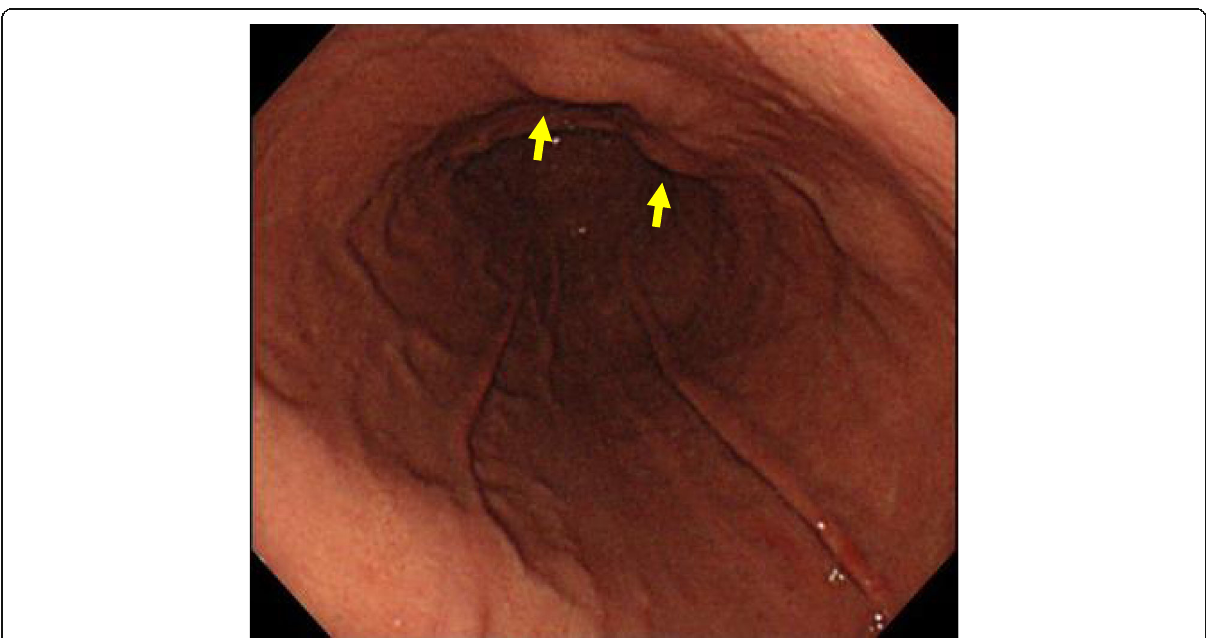
stomach (yellow arrow). This suggested SMT